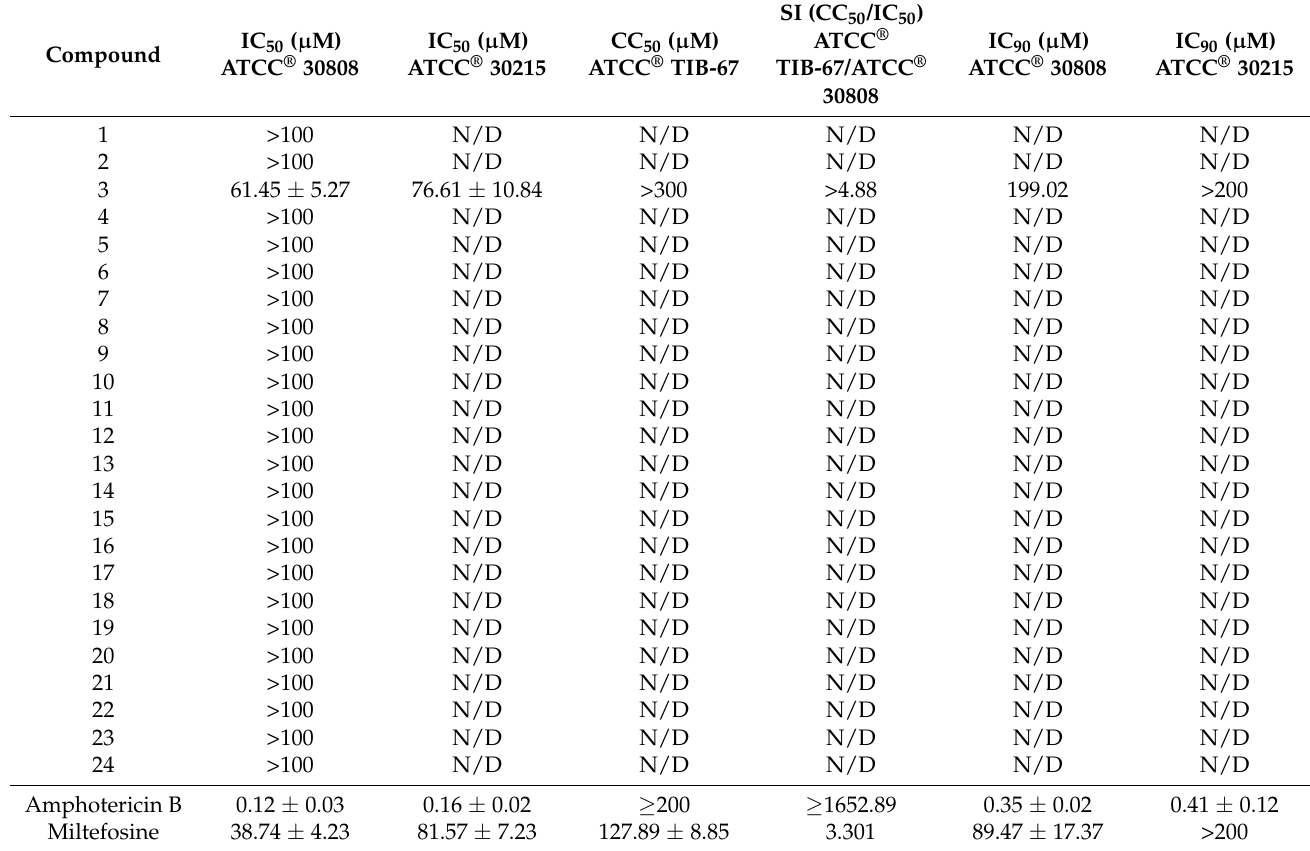
Table 1. Inhibitory concentrations (IC 50 /IC 90 ) of the evaluated compounds against the trophozoite stage of Naegleria fowleri type strains ATCC ® 30808™ and ATCC ® 30215™, and cytotoxicity values (CC 50 ) against murine macrophages J774A.1 strain ATCC ® TIB-67™. N/D indicates that values were not determinate. The selectivity index (SI) of the active compounds was also